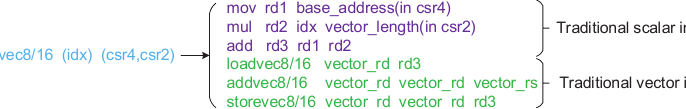
Figure 15. The load-rd-add-rs-store-rd-vec8/16 instruction equivalent.